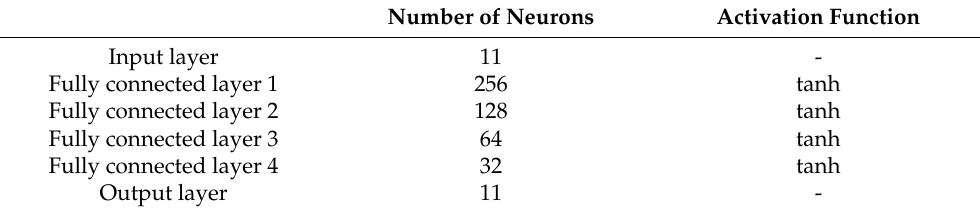
Table 2. Structure of generator.